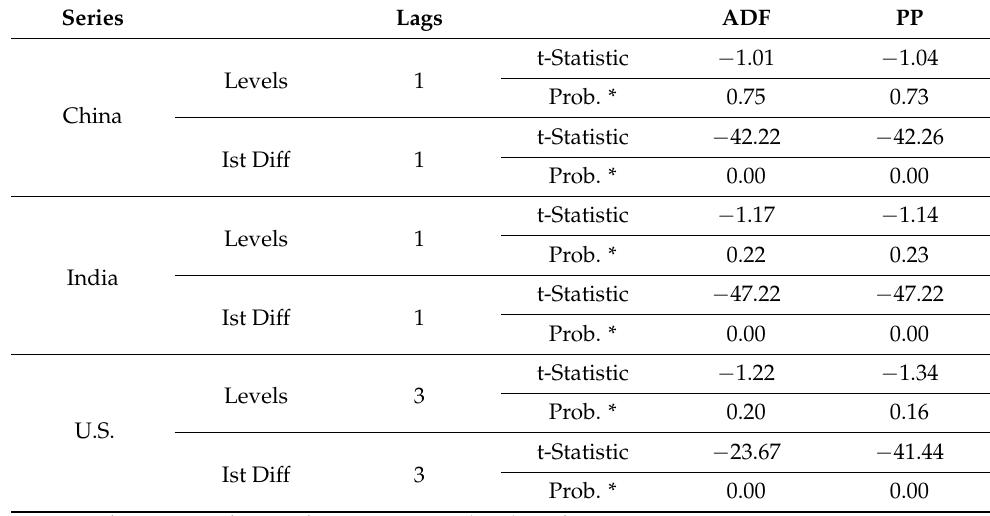
Table 4. Augmented Dickey Fuller (ADF) and Phillips Perron (PP) tests.